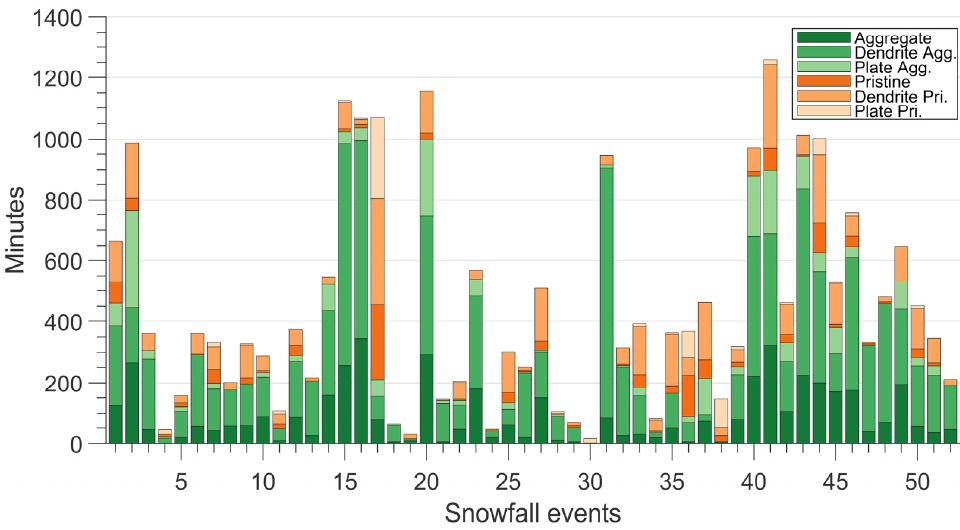
Figure 7. Minutes of precipitation for each snow category and for each of the 52 snowfall events investigated in this work.